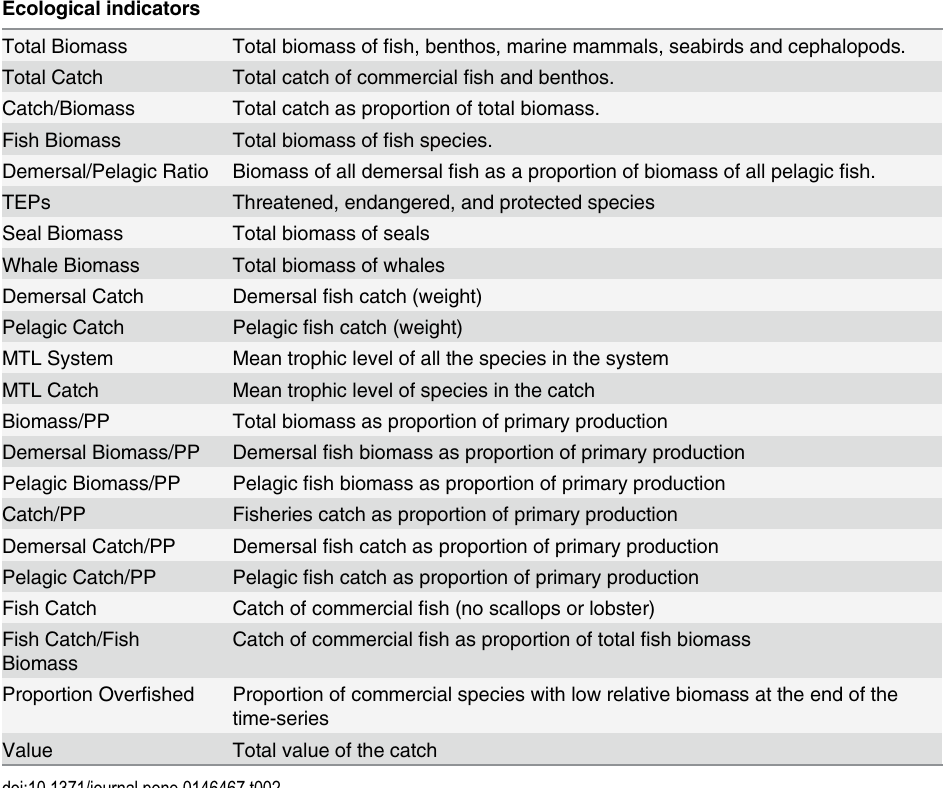
Table 2. List of ecosystem indicators calculated from the NEUS model data and the survey biomass and observed landings data. Ecological indicators Total Biomass Total biomass of fi sh, benthos, marine mammals, seabirds and cephalopods. Total catch of commercial fi sh and